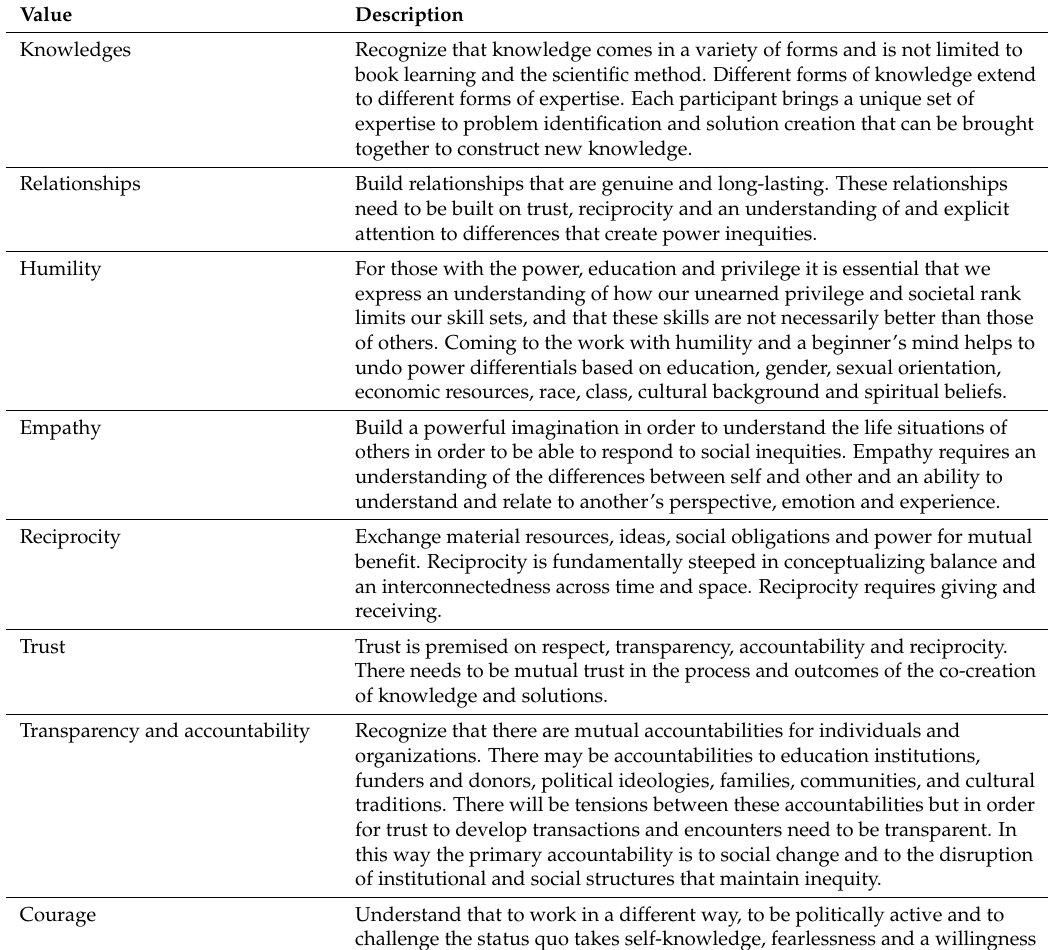
Table 1. Underlying Values for Sharing